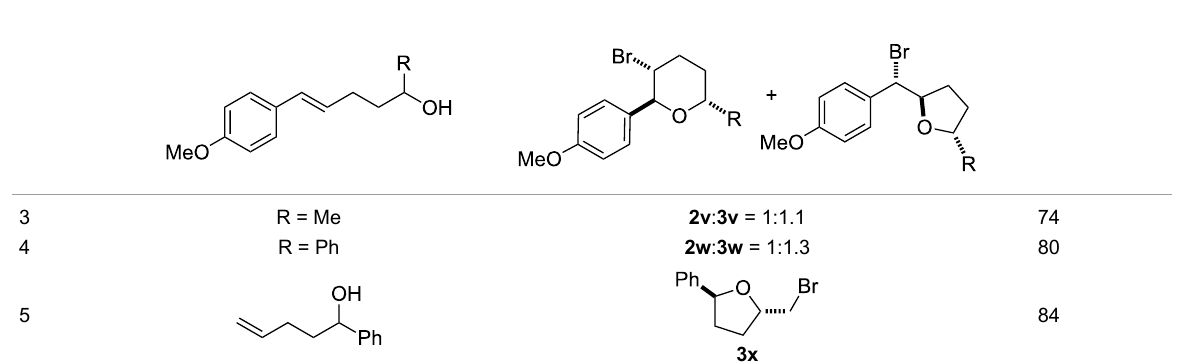
Table 3: Photocatalytic bromoetherification of pentenols a .